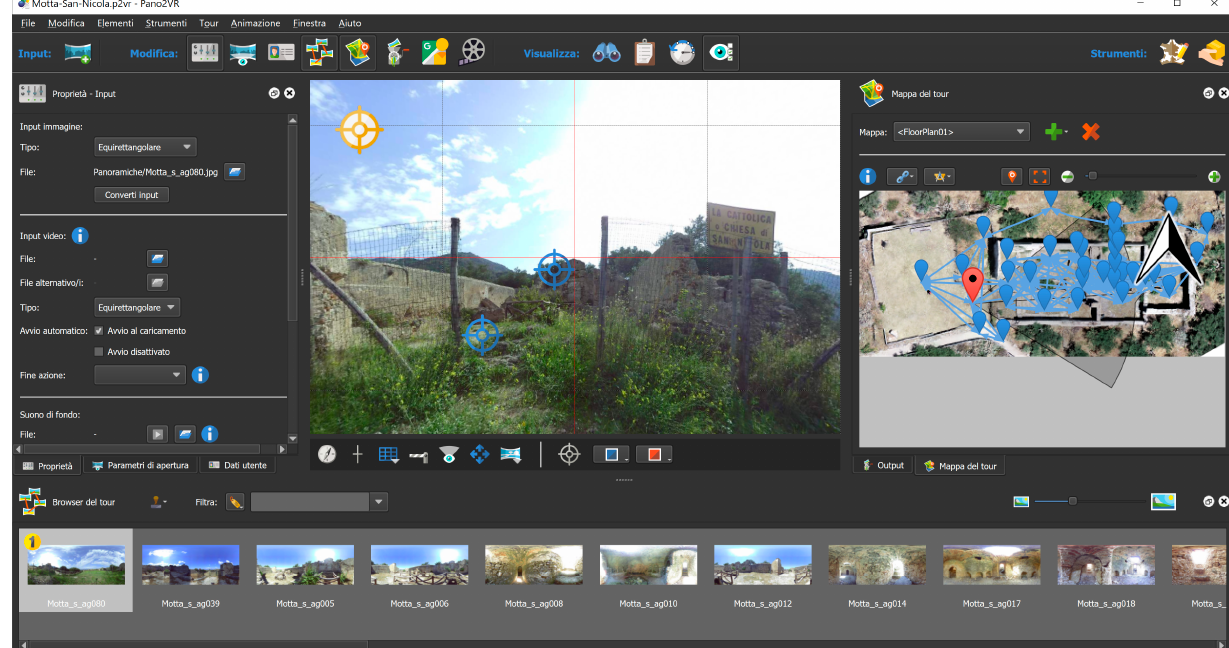
Figure 21. Pano2Vr virtual tour project.